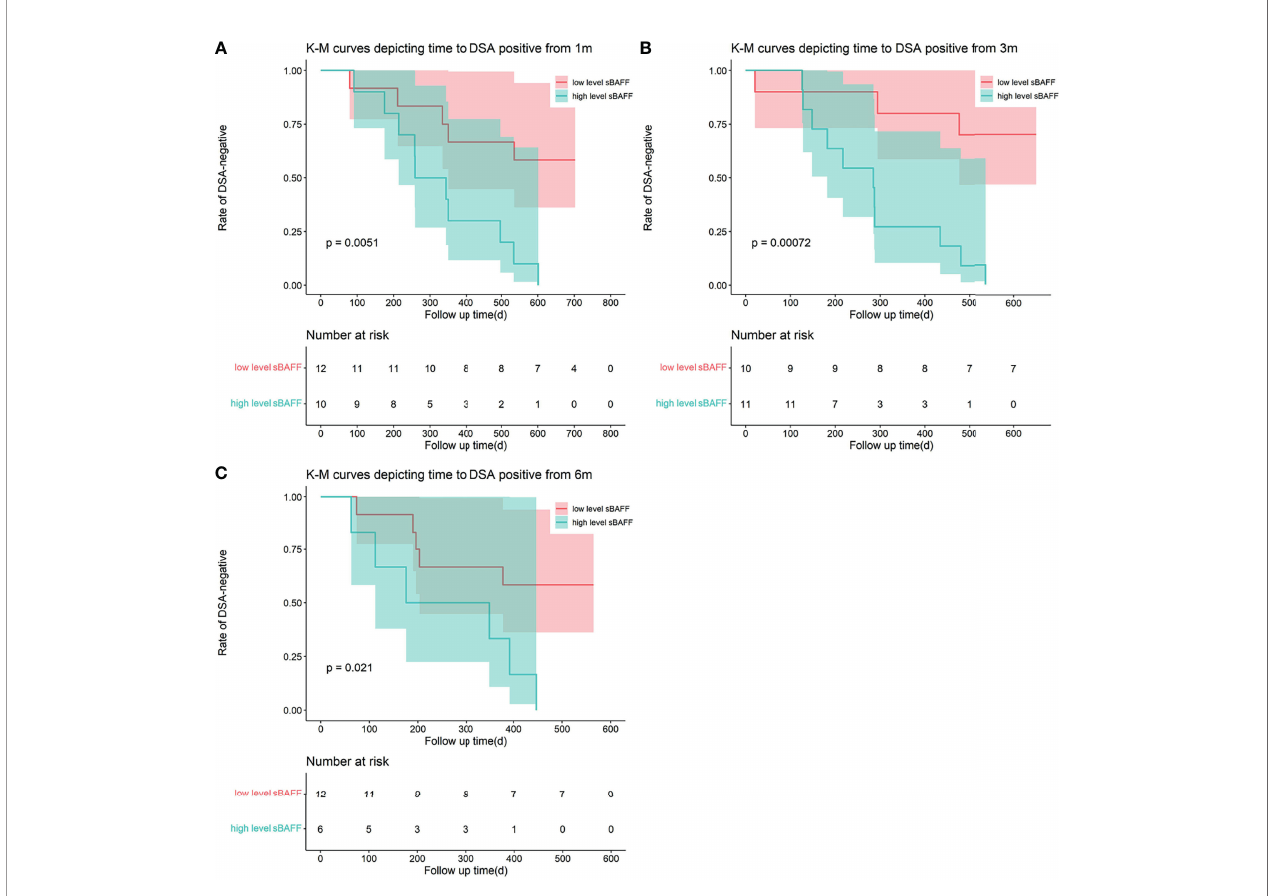
FIGURE 6 | Kaplan – Meier curves depicting time to the occurrence of dnDSA from 1 month (m), 3 m, and 6 m after transplantation. The recipients were divided into two groups according to the cutoff calculated by the receiver operating characteristic (ROC). (A – C) High-level soluble B cell-activating factor (sBAFF) at 1 m, 3 m, and 6 m was a risk factor for the occurrence of the dnDSA.